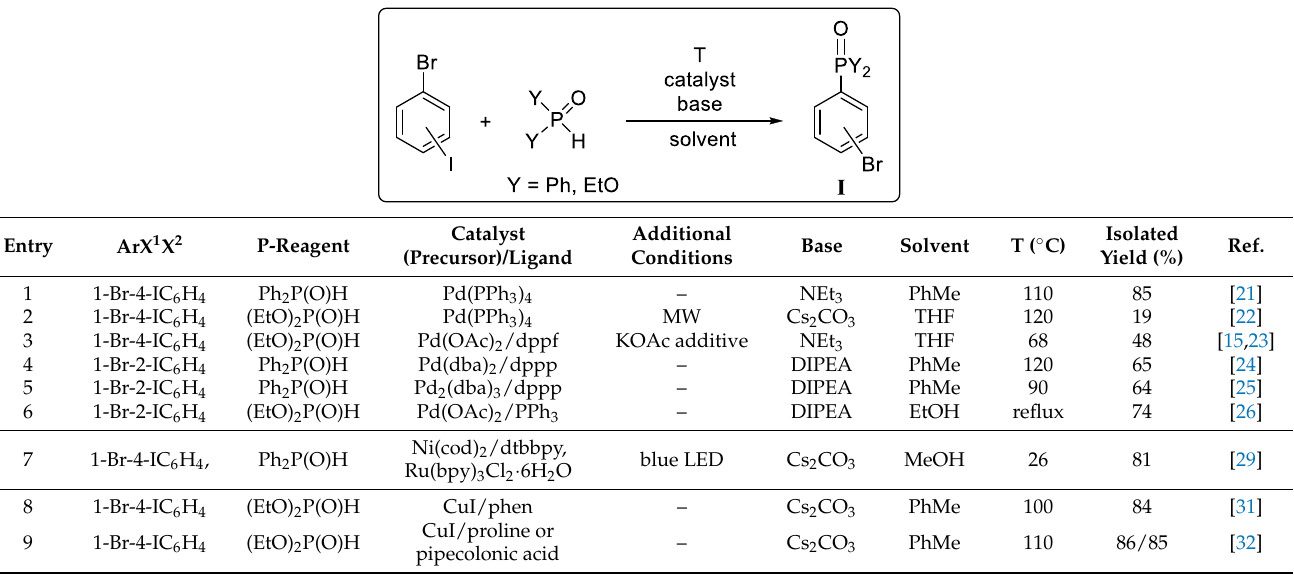
Table 1. P – C coupling reactions of bromo-iodobenzenes in the presence of different catalysts/pre- cursors – a literature